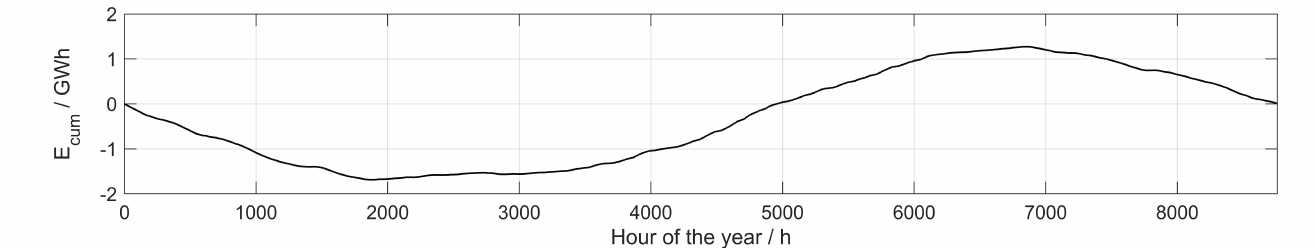
Figure 15. Annual performance of the BTES: Aggregated energy within the BTES and the surrounding ground.